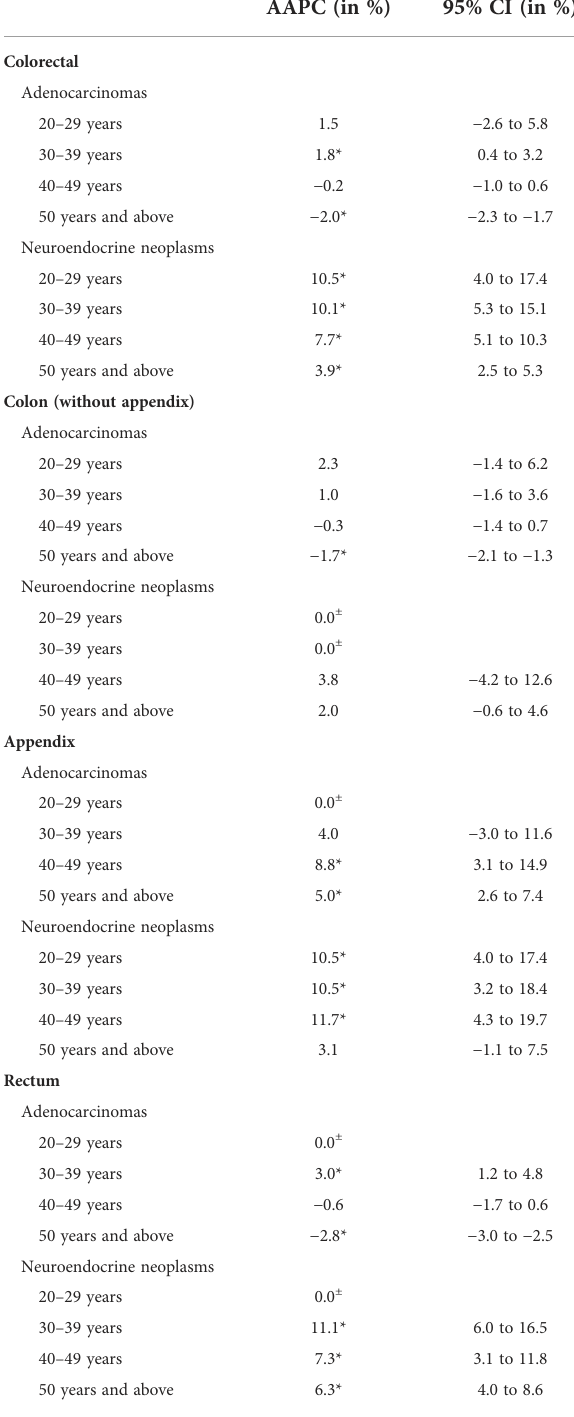
TABLE 3 Average annual percentage change in age-standardized incidence rates for colorectal cancer cases from 2005 to 2019 by anatomic site, histological subgroup, and age in